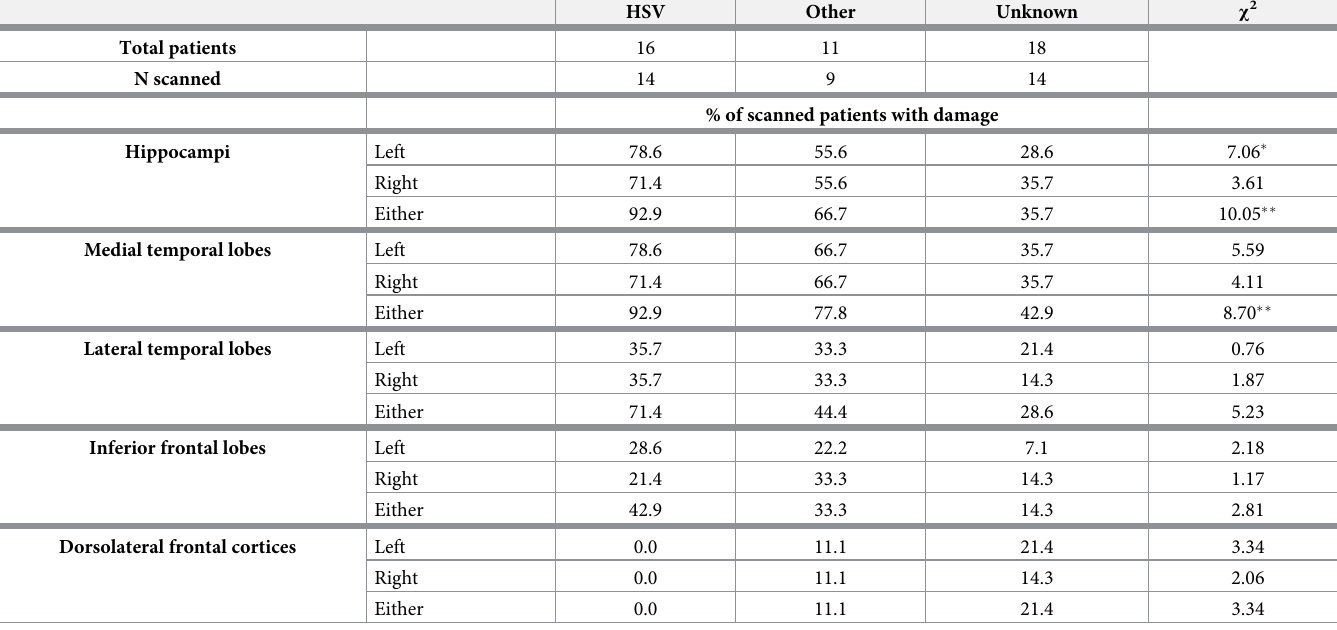
Table 4. Prevalence (%) of damage across brain regions in each encephalitis group on MRI.